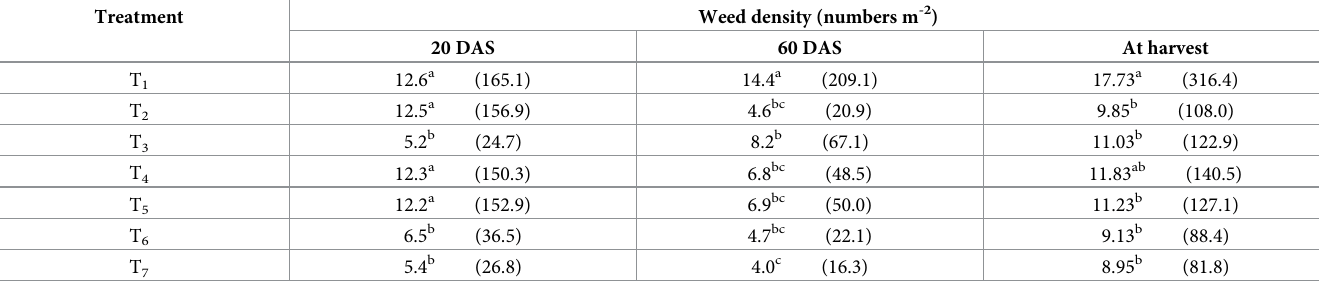
Table 2. Effect of different weed management practices on weed densities at different growth stages in soybean.